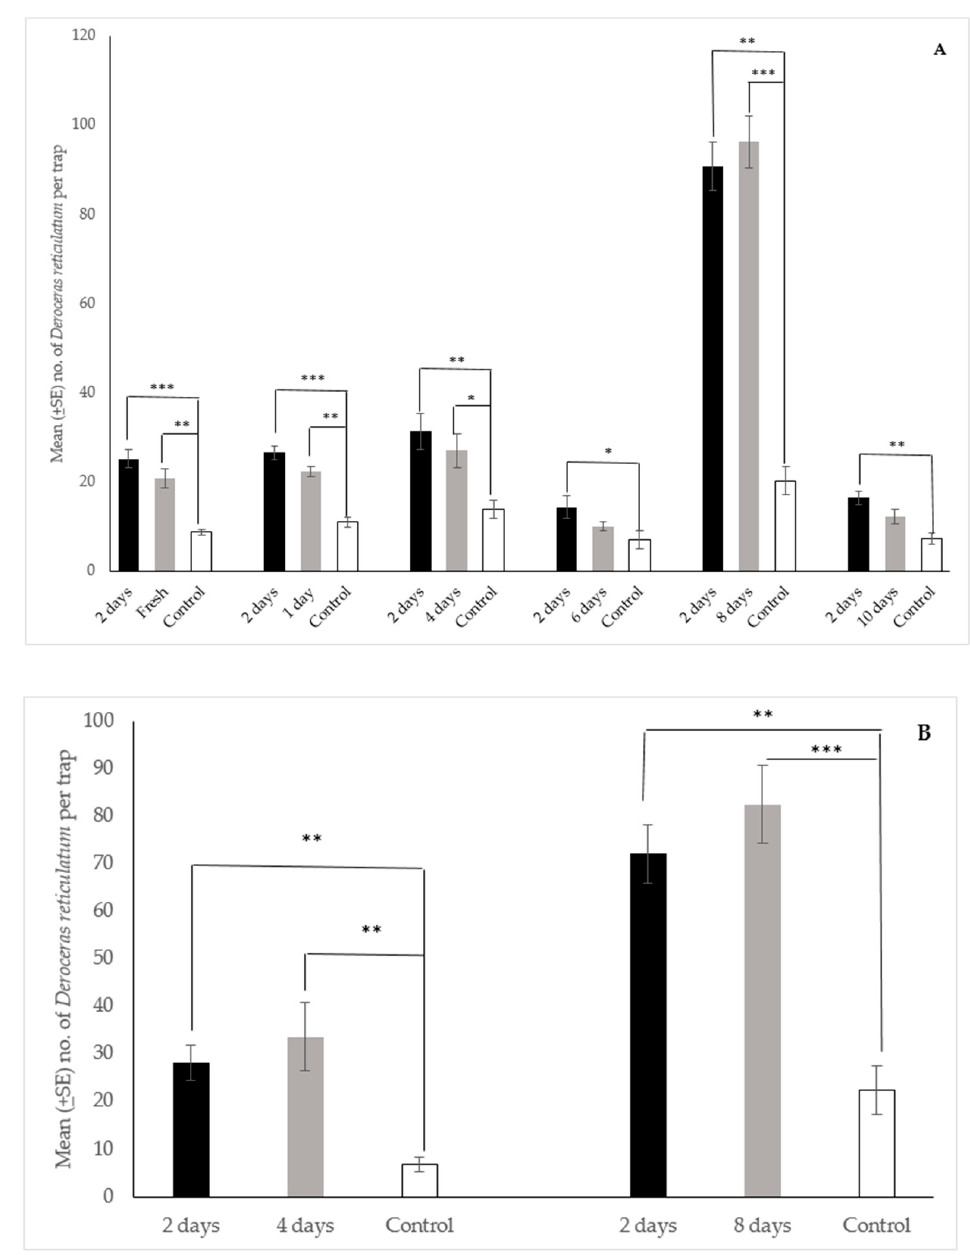
Figure 6. Mean ( ± SE) number of Deroceras reticulatum collected per Snailer ® trap over 24 h with original spacing i.e., 30 cm ( A ) and increased spacing i.e., 1 m ( B ) between traps. Traps baited with 2- day aged dough, dough of various ages, or a water control in field trials in Oregon. Traps also contained liquid metaldehyde at labeled rate. Kruskal-Wallis Test (n = 10, df = 2), pairwise post-hoc tests with significance values adjusted by the Bonferroni correction for multiple tests. Bars with asterisks indicate significant differences (* p < 0.05, ** p < 0.01, *** p < 0.001) between the median values. ( A ). Original trap spacing: Fresh dough—H = 18.17, p = 0.000; 2 day vs. control, test statistic = 4.09, p < 0.001; fresh vs. control, test statistic = 3.09, p < 0.01; 1-day old dough—H = 20.56, p = 0.000; 2 day vs. control, test statistic = 4.44, p < 0.001; 1 day vs. control, test statistic = 3.01, p < 0.01; 4-day old dough—H = 11.92, p = 0.003; 2 day vs. control, test statistic = 3.31, p < 0.01; 4 day vs. control, test statistic = 2.50, p < 0.05; 6-day old dough—H = 8.15, p = 0.017; 2 day vs. control, test statistic = 2.81, p < 0.05; 8-day old dough—H = 19.42, p = 0.000; 2 day vs. control, test statistic = 3.70, p < 0.01; 8 day vs. control, test statistic = 3.93, p < 0.001; 10-day old dough—H = 14.19, p = 0.001; 2 day vs. control, test statistic = 3.73, p < 0.01. ( B ). Increased trap spacing: 4-day old dough—H = 16.94, p = 0.000; 2 day vs. control, test statistic = 3.58, p < 0.01; 4 day vs. control, test statistic = 3.55, p < 0.01; 8-day old dough—H = 18.61, p = 0.000; 2 day vs. control, test statistic = 3.49, p < 0.01; 8 day vs. control, test statistic = 3.94, p <